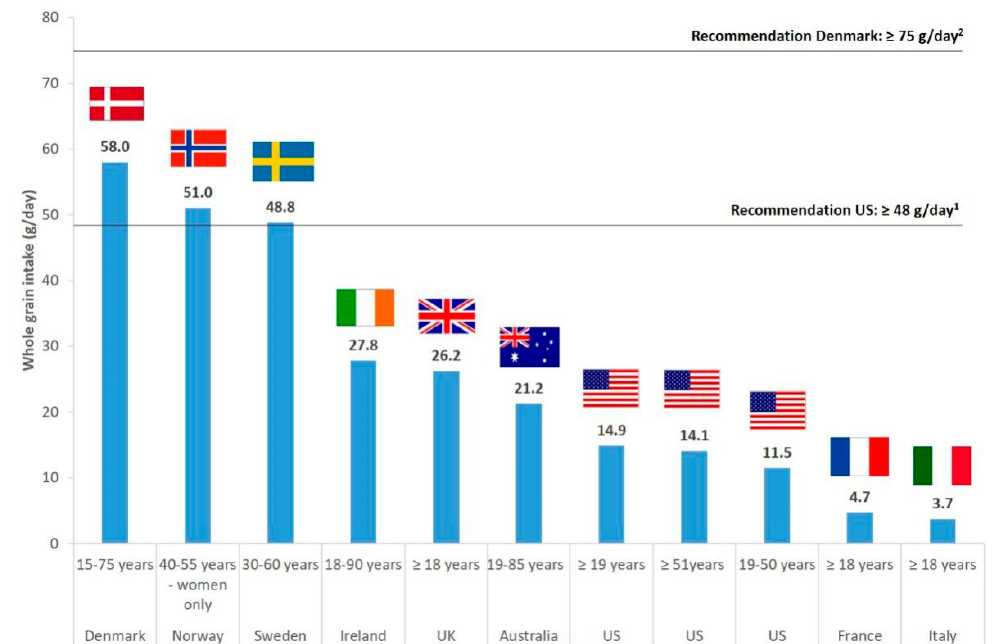
Figure 2. Whole grain daily intakes in adults in several countries as reported by nationally representative dietary surveys (except if specified otherwise). Reported intakes are expressed in grams of whole grain ingredients and correspond to mean intakes in all cases, except for Australia where medians are reported. 1 Recommendation for whole grain consumption for adults, as reported in the Dietary Guidelines for Americans 2015 (see Table 1 for details). 2 Recommendation for whole grain consumption for adults, as reported in the Danish dietary guidelines (see Table 1 for details).